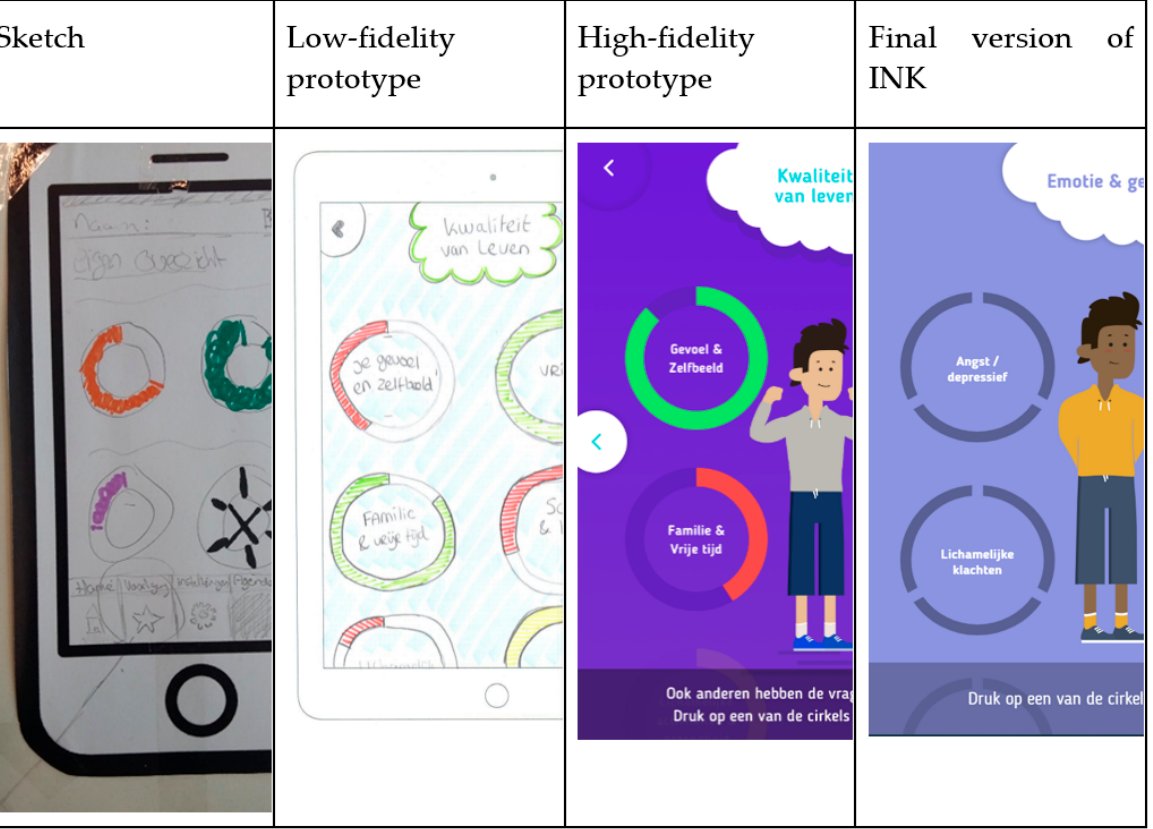
Figure 4. Use of traffic light colours in